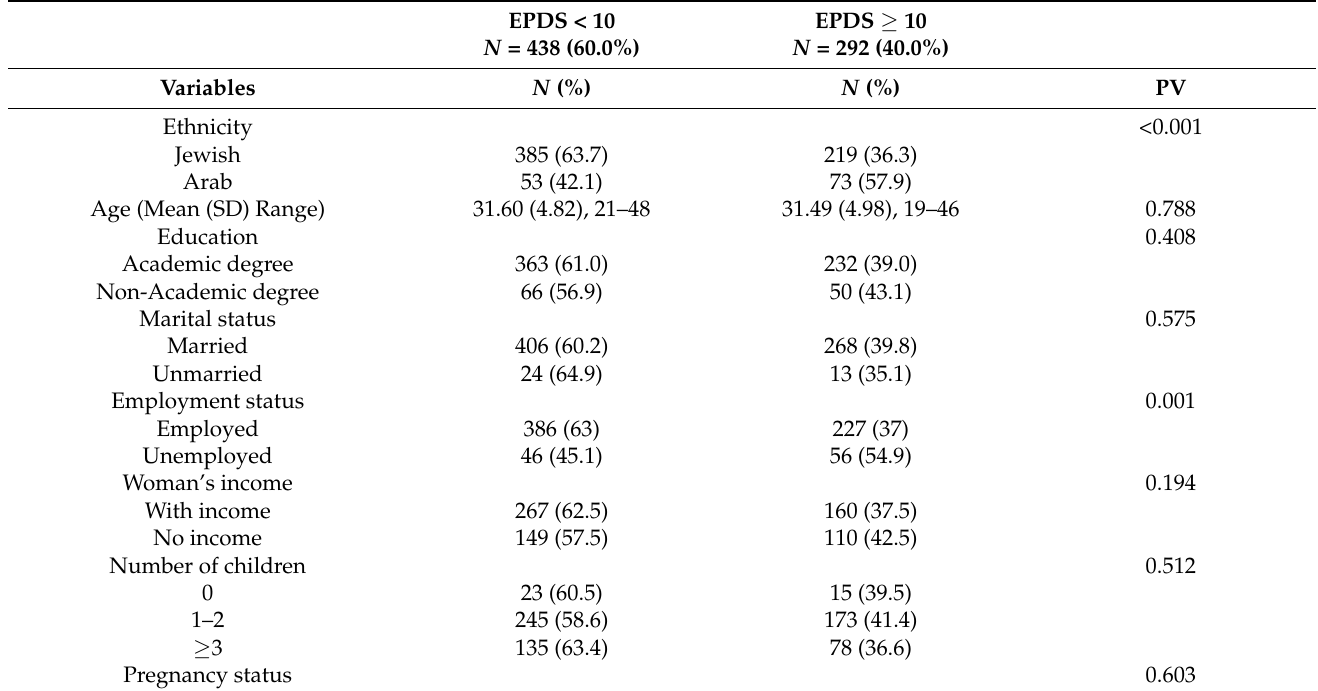
Figure 1. Prevalence of perinatal depression symptoms in total study sample and in Jewish and Arab women. p = significance level for the association between Arab and Jewish women (Chi-square test). Table 2. Individual characteristics and risk factors related to COVID-19 and associations with PNDS (N =